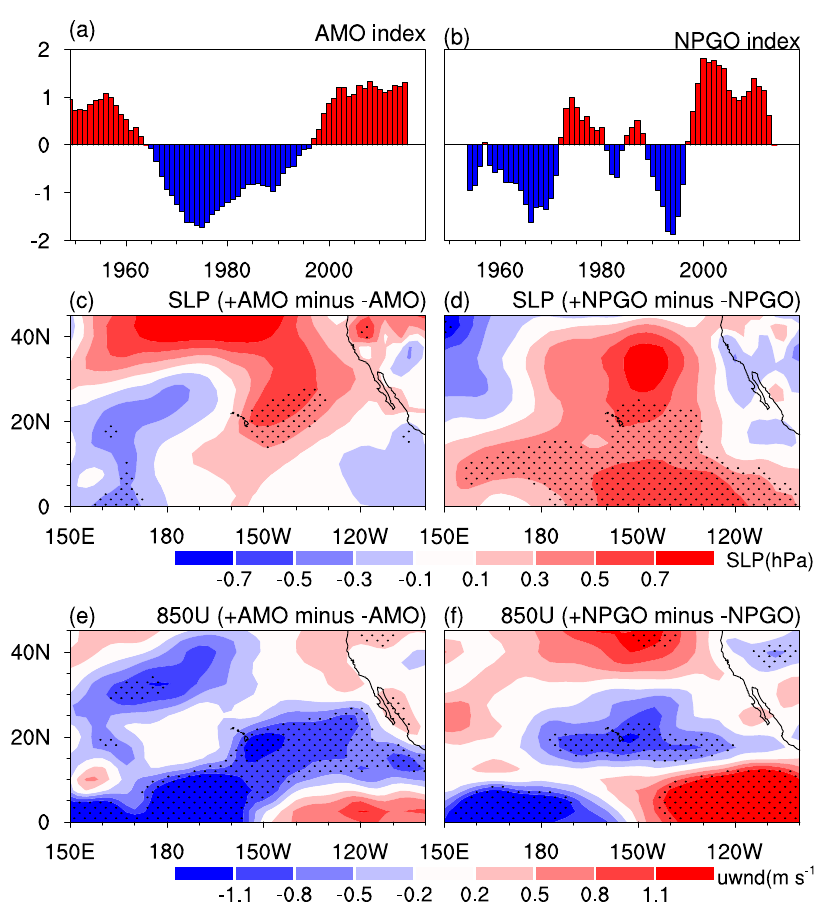
Fig. 6 Modulations of the AMO and NPGO on the Paci fi c mean states in the observations. Normalized time series of the annual mean a AMO index and b NPGO index with 9-year running mean. Differences in the climatology of spring SLP c between positive and negative AMO phases, and d between positive and negative NPGO phases. e , f as in c , d , but for differences in the climatology of spring 850-hPa zonal wind between different phases of the AMO and NPGO. Stippling regions in c – f indicate the differences that are signi fi cantly different from zero at the 95% con fi dence